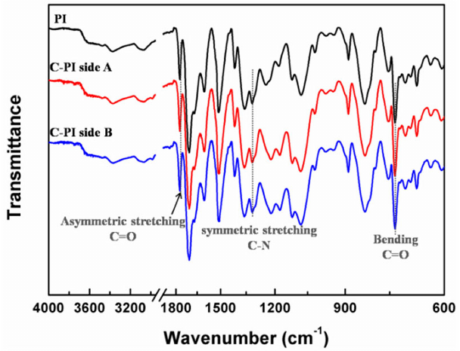
Figure 12. FTIR spectra of PI membranes before and after coated with SiO 2 antireflective membrane. The FTIR spectras of PI composite membrane have been tested on both